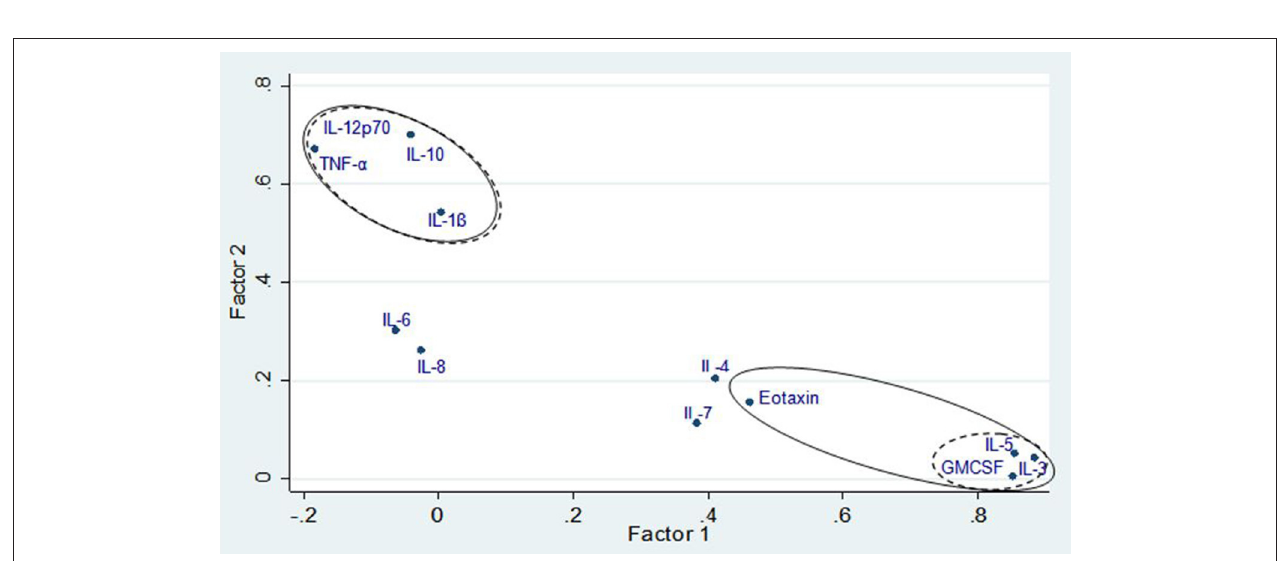
FIGURE 2 | Factor loading plot for principal factor analysis showing factor groupings with and without Varimax rotation. Solid line denotes variable loadings included in factors without rotations and dashed lines denote variable loadings included in factors with Varimax